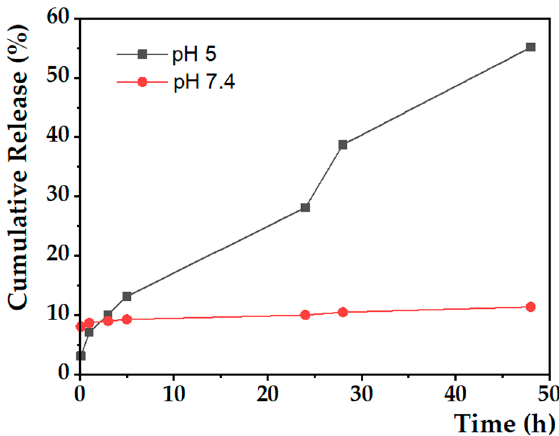
Figure 7. Cumulative release profiles (average of three replicas) of doxorubicin (%) over time (h) encapsulated in SMLs at pH = 5 (gray line) and pH = 7.4 (red line).